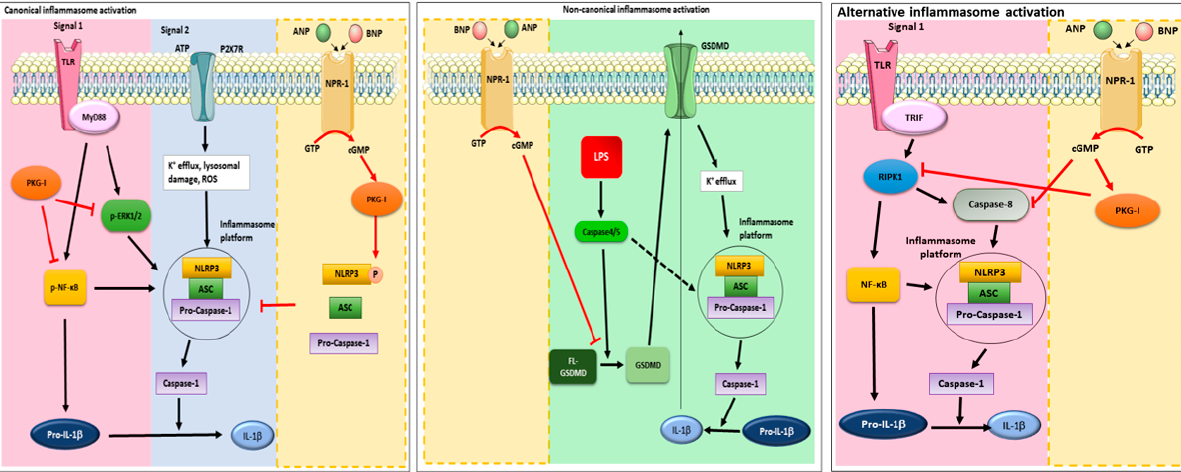
Figure 6. NPs interfere with canonical, non-canonical and alternative routes of inflammasome activation. Canonical inflammasome activation requires two signals: the first, represented by TLR-ligand engagement, involves NF- κ B and ERK1/2 activation and culminates in the increased expression of pro-IL-1 β and PRRs, such as NLRP3; the second, provided by stress signals, results in Caspase-1 activation and pro-IL-1 β cleavage. NPs, by binding to NPR-1 induce an intracellular increase in cGMP which activates PKG-I. This latter is responsible for NF- κ B and ERK1/2 inhibition and possibly for the phosphorylation of NLRP3, thus impeding the assembly of the inflammasome platform. Non-canonical inflammasome signaling depends on the activation of Caspase-4 and -5 in human by a direct binding to cytosolic LPS. Caspase-4/5 process Gasdermin D which translocates to the plasma membrane forming pores that may cause K+ efflux responsible for inflammasome platform assembly. Moreover, Gasdermin D may serve as a conduit for the release of IL-1 β . NPs-induced increase in intracellular cGMP levels inhibits Gasdermin D cleavage. Alternative inflammasome activation pathway culminates, upon TLR4 engagement, TRIF and RIPK1 endorsement, in the cleavage of Caspase-8 which can directly cleave pro-IL-1 β or regulate the NLRP3 inflammasome. PKG-I, activated by cGMP, reduced RIPK1 expression levels. Moreover, the intracellular cGMP rise evoked by NPs leads to inhibition of Caspase-8 cleavage.